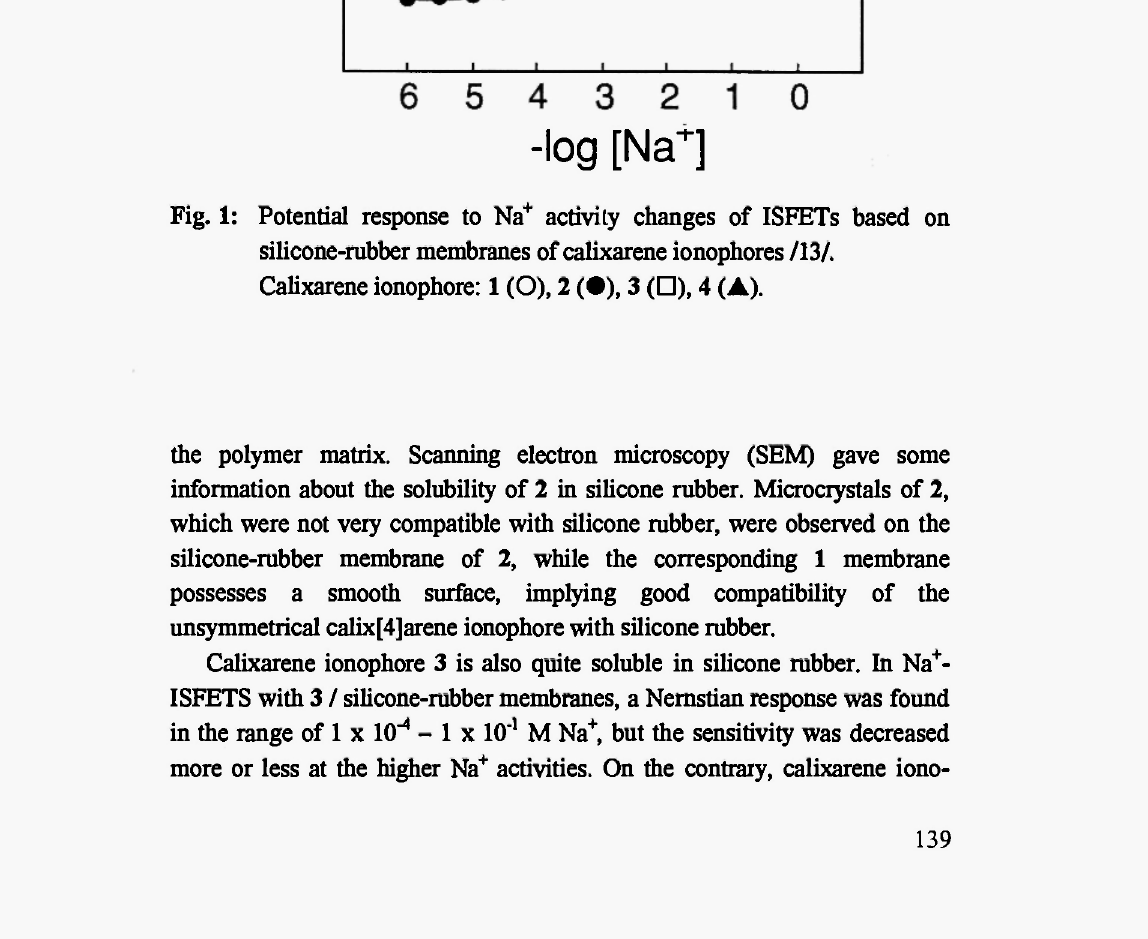
Fig. 1: Potential response to Na + activity changes of ISFETs based on silicone-rubber membranes of calixarene ionophores